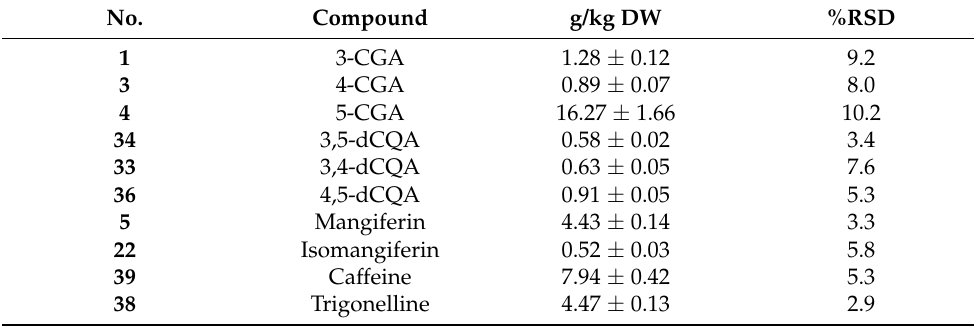
Table 4. Concentration of major bioactive compounds found in C. arabica L. leaves extracts.